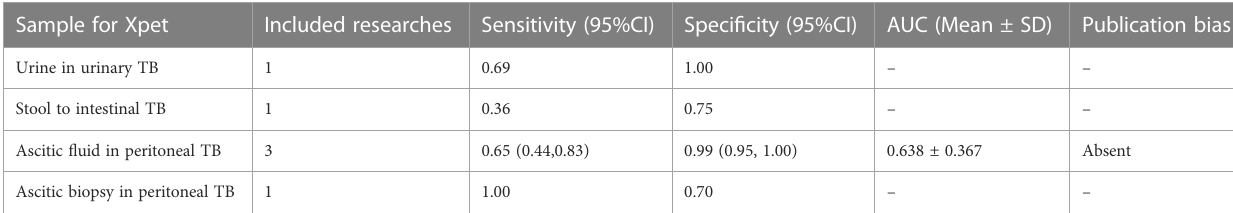
TABLE 2 Summary of pooled results on other types of